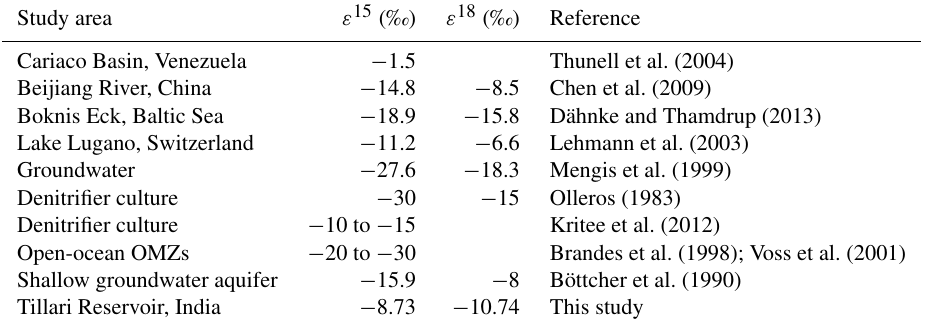
Table 1. The values of nitrogen ( ε 15 ) and oxygen ( ε 18 ) isotope effects for denitrification as reported from some natural systems as well as laboratory cultures. Study area